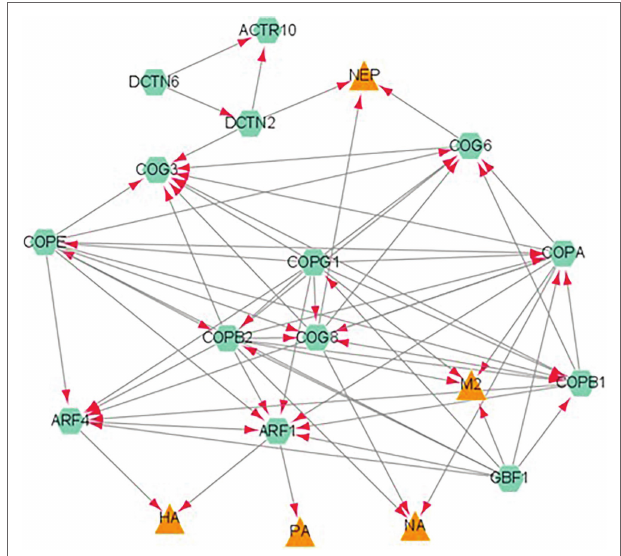
FIGURE 3 | A network analysis of influenza proteins and host proteins involved in ER protein processing. Proteins classified as belonging to the ER protein processing pathway were analyzed by STRING database. The viral proteins are represented by orange triangles and host interactors are represented by green hexagons. Each interaction is represented by edges connecting the two nodes with the arrow reflecting a positive association between two